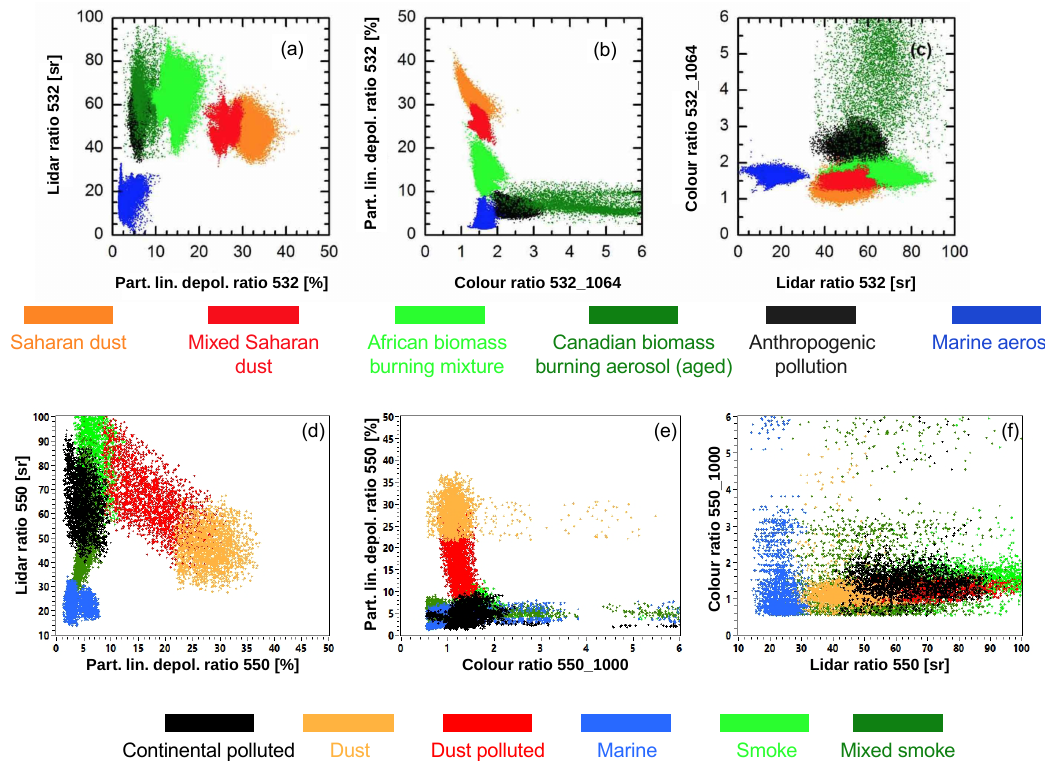
Figure 4. Characteristic quantities of various atmospheric aerosol types form lidar measurements ( a – c , adapted from Groß et al., 2013, their Fig. 5) and from synthetic measurements (d–f) . (a, d) Lidar ratio versus linear particle depolarization. (b, e) Linear particle depolarization versus colour ratio. (c, f) Colour ratio versus lidar